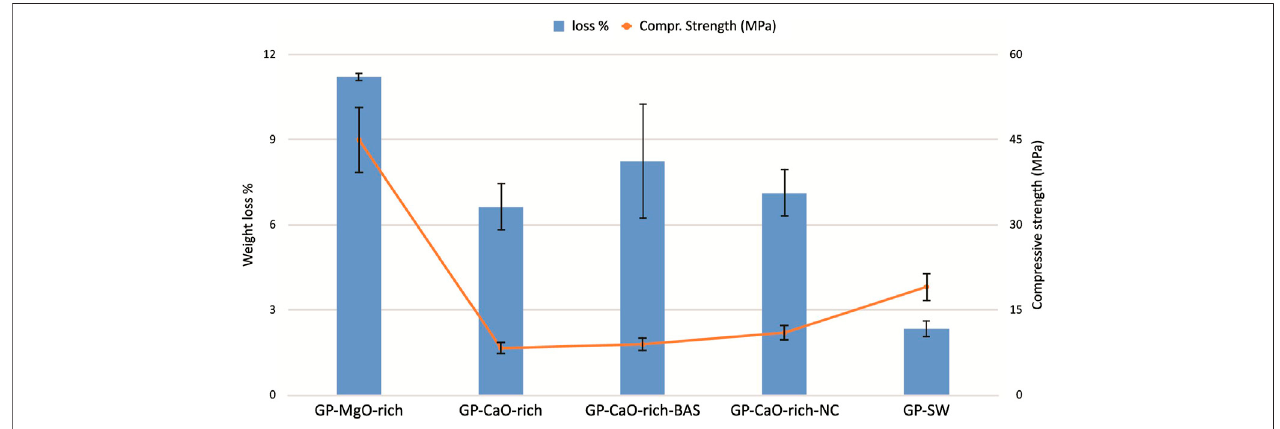
FIGURE 2 | Weight Loss (%) and compressive strength (MPa) of the alkali activated materials.